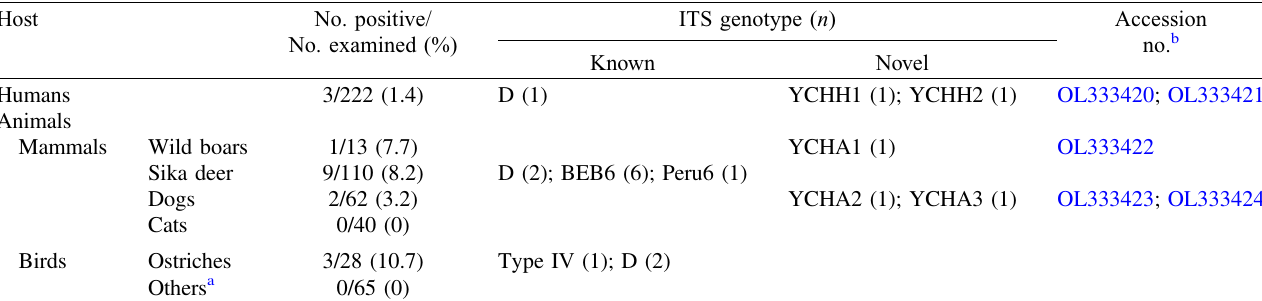
Table 2. Prevalence and genotype distribution of E . bieneusi in humans and animals in